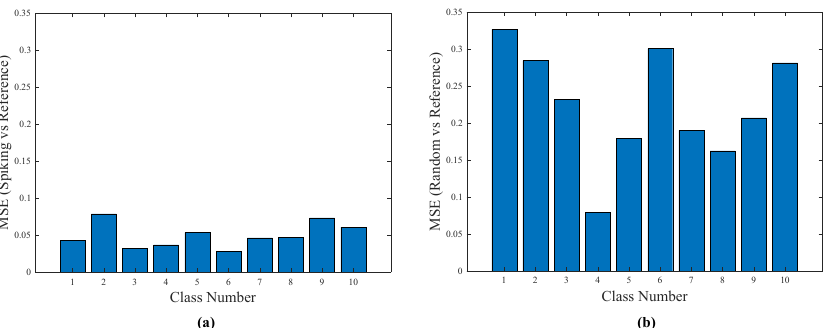
Figure 6. Values of centers. ( a ) Value of Centers in Dimension 1. ( b ) Value of Centers in Dimension 2. ( c ) Value of Centers in Dimension 3.